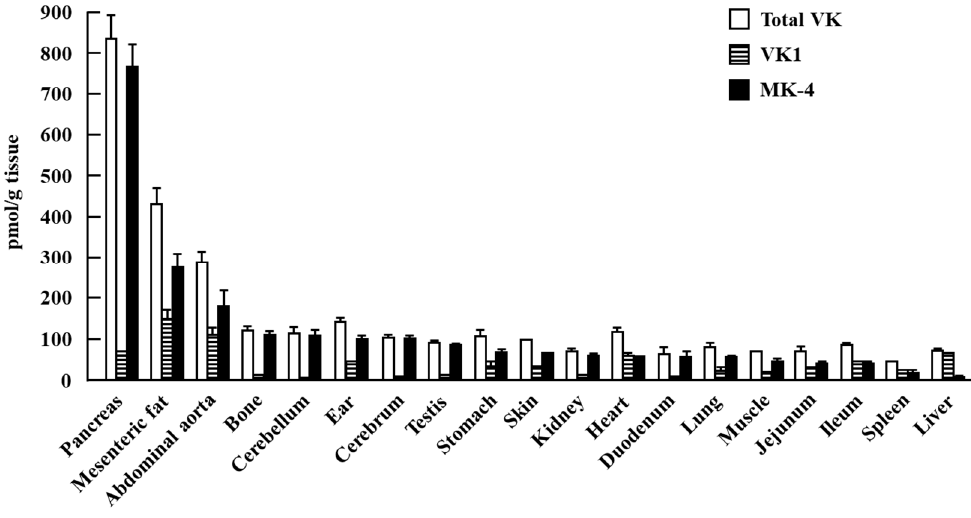
Figure 1. Vitamin K status of male Wistar rat tissues. Rats were fed a standard AIN-93G rodent diet for three weeks. The levels of vitamin K in tissues were determined using fluorescent high-performance liquid chromatography. MK-4: menaquinone-4. (Reproduced from Ref. [17].)